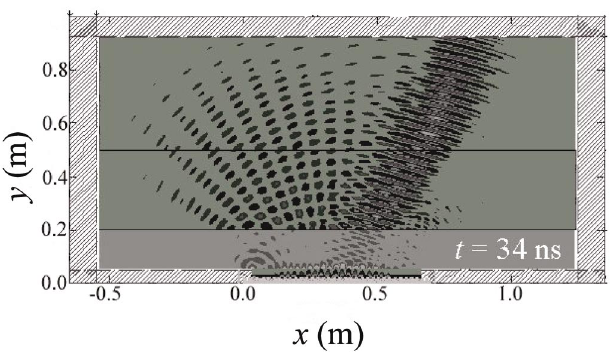
FIG. 3. x - y contour map of B